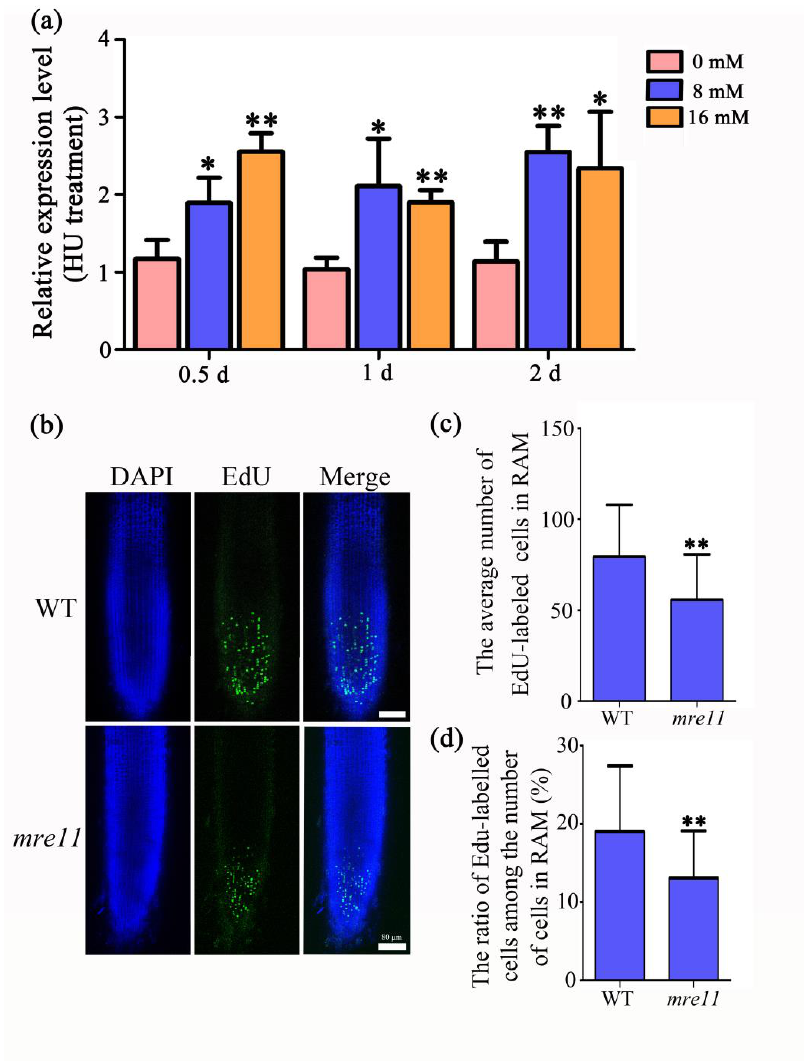
Figure 6. OsMre11 is involved in DNA replication of rice root. OsMre11 is involved in DNA replication of rice root. ( a ) Relative expression level of Mre11 with the treatment of HU. The concentration of HU is 0, 8, and 16 mM. The materials were collected after the treatment of 0.5, 1, and 2 days. ( b ) Signals of ethynyl deoxyuridine (EdU) staining in 7DAG roots of rice WT and mre11 seedlings. DAPI is 4 (cid:48) , 6-diamidino-2- phenylindole dihydrochloride. Scale bars represent 80 µ m. ( c ) The average number of EdU-labeled cells in root apical meristem. ( d ) The ratio of EdU-labeled cells among the number of cells in root apical meristem. The numbers of WT and the mre11 are 24 and 18, respectively. The asterisks represent a statistically significant difference according to Student’s t -test (*, p < 0.05; **, p <